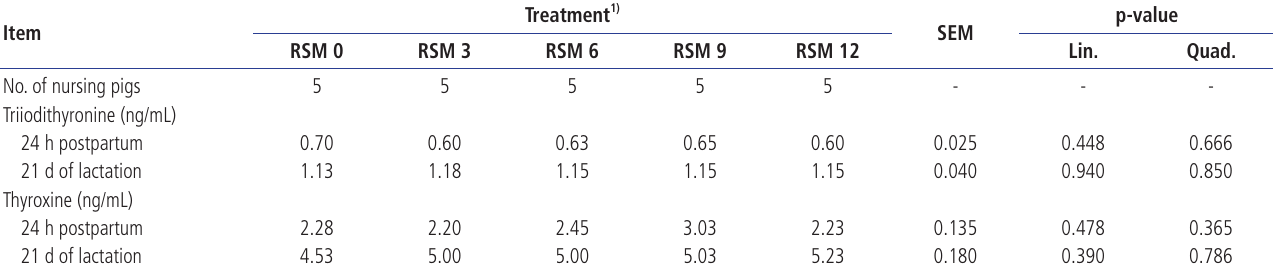
Table 7. Effect of rapeseed meal (RSM) supplementation levels in gestation diets on serum triiodithyronine (T3) and thyroxine (T4) concentrations in